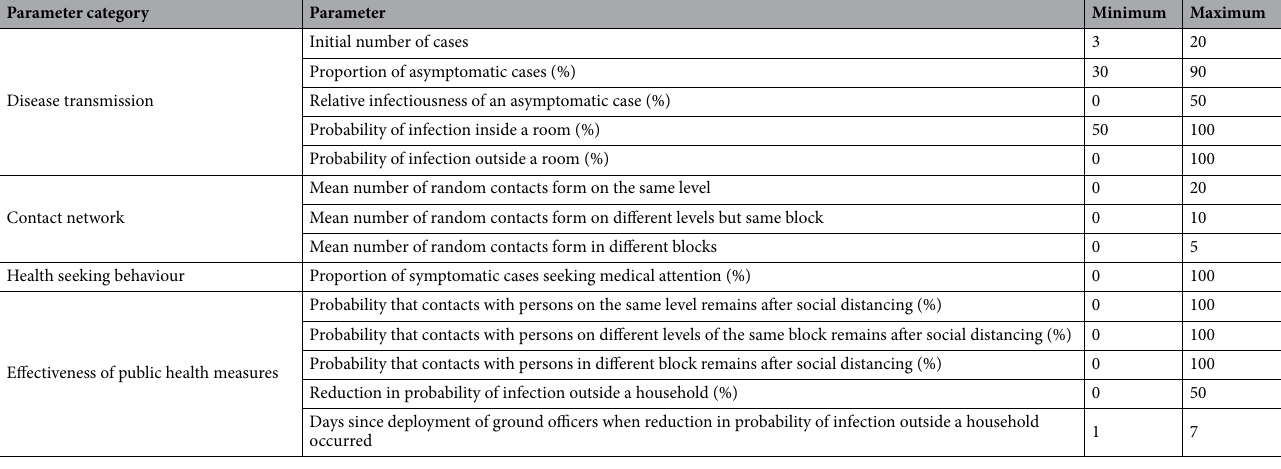
Table 3. Range of values for each parameter in a parameter